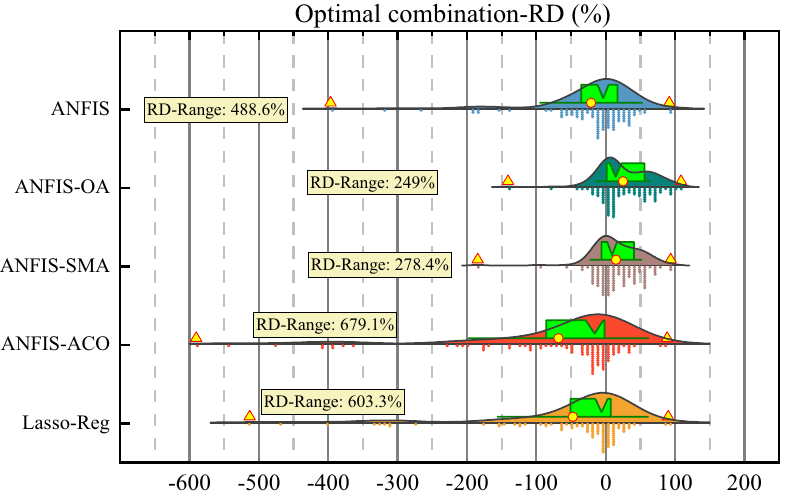
Figure 11. Relative devotion to the predictive model in the optimal scenario for diagnostic analysis for the testing stage.